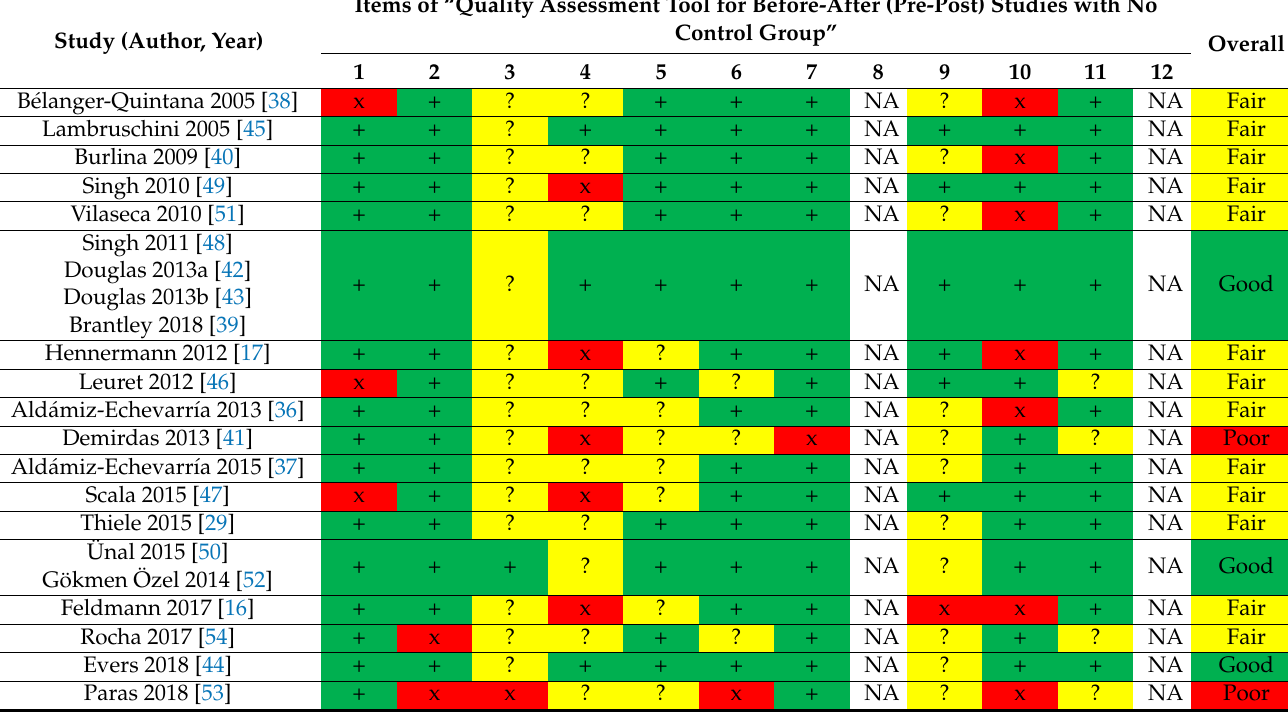
Table 3. Quality appraisal and risk of